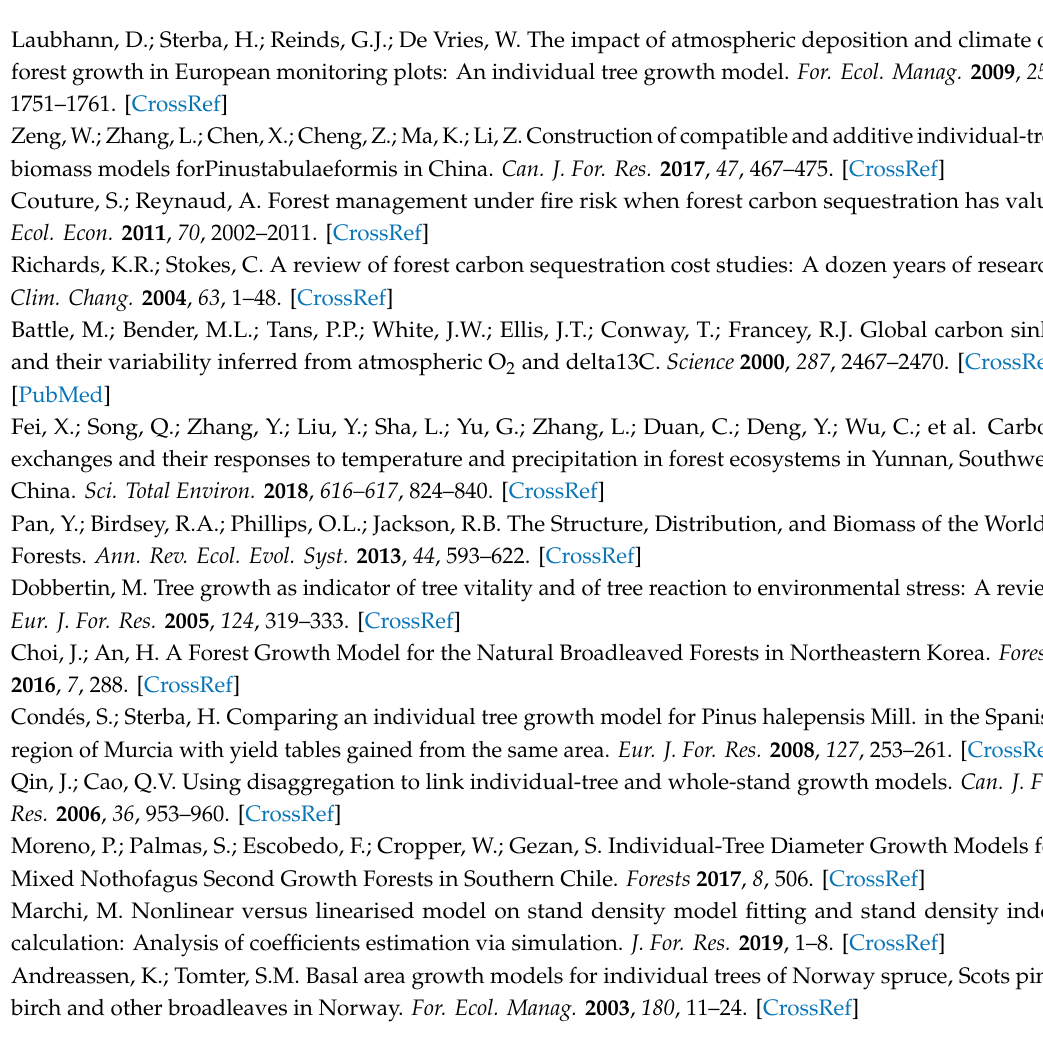
Betula platyphylla